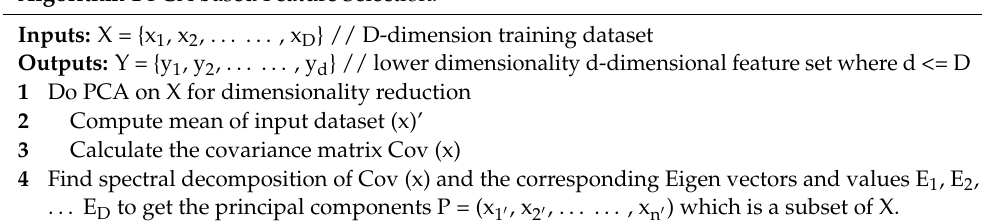
Algorithm 1 PCA based Feature